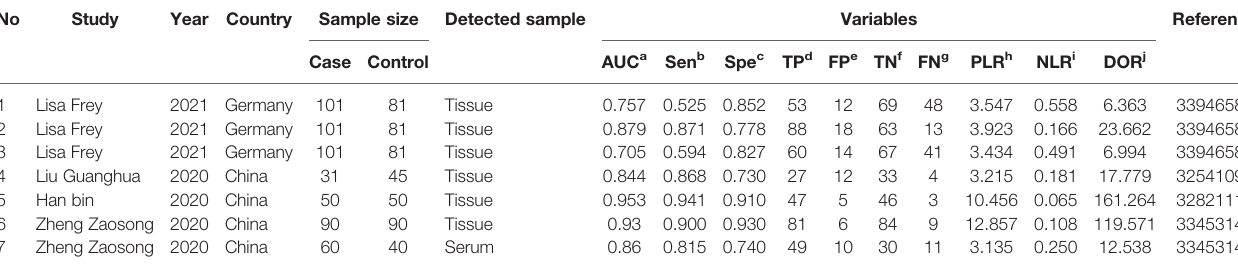
TABLE 2 | Main characteristics of studies related to diagnosis included in the meta-analysis.